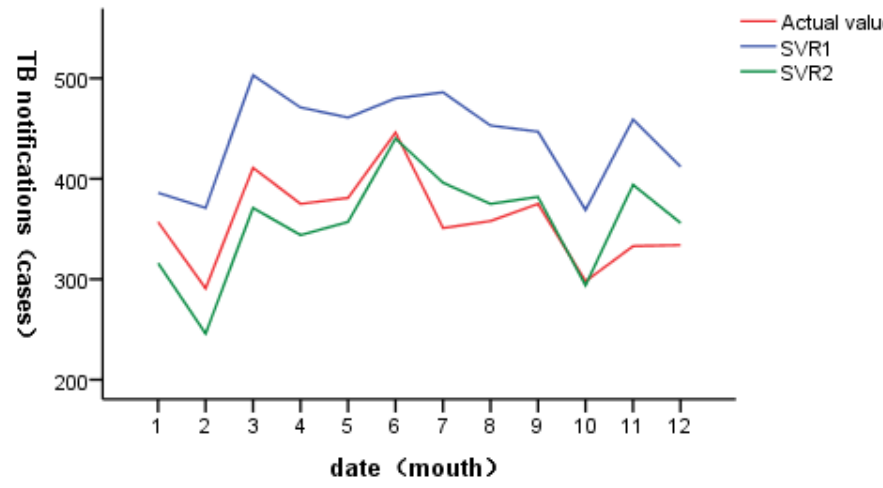
Figure 4. Prediction results of support vector regression (by monthly statistics).